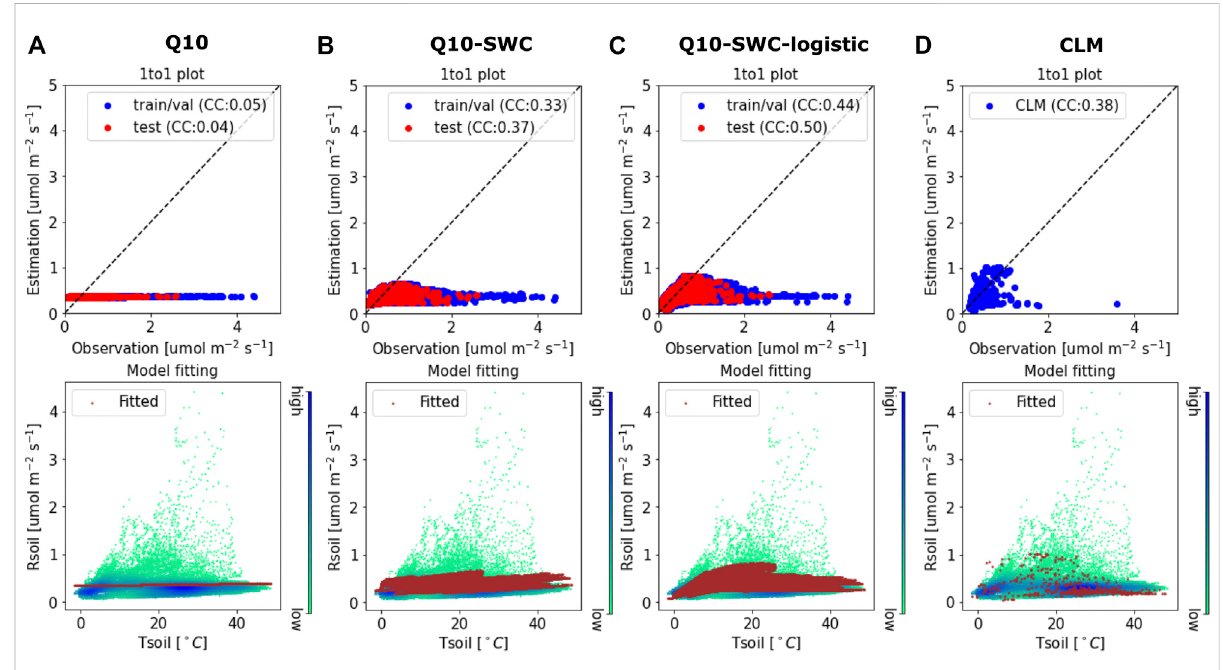
FIGURE 3 ThecalibratedQ10-basedmodelsandCLMsimulation. (A) Thetrainingandtestperformancesandmodel fi ttingofthecalibratedQ10equation: Rsoil (cid:2) 0 . 351 × 1 . 028 Tsoil − 10 10 (B) The training and test performances and model fi tting of the calibrated SWC-dependent Q10 equation: Rsoil (cid:2) 0 . 109 × 1 . 172 Tsoil − 10 10 × SWC 0 . 586 (C) the performance and model fi tting of the calibrated SWC-dependent logistic power equation: Rsoil t